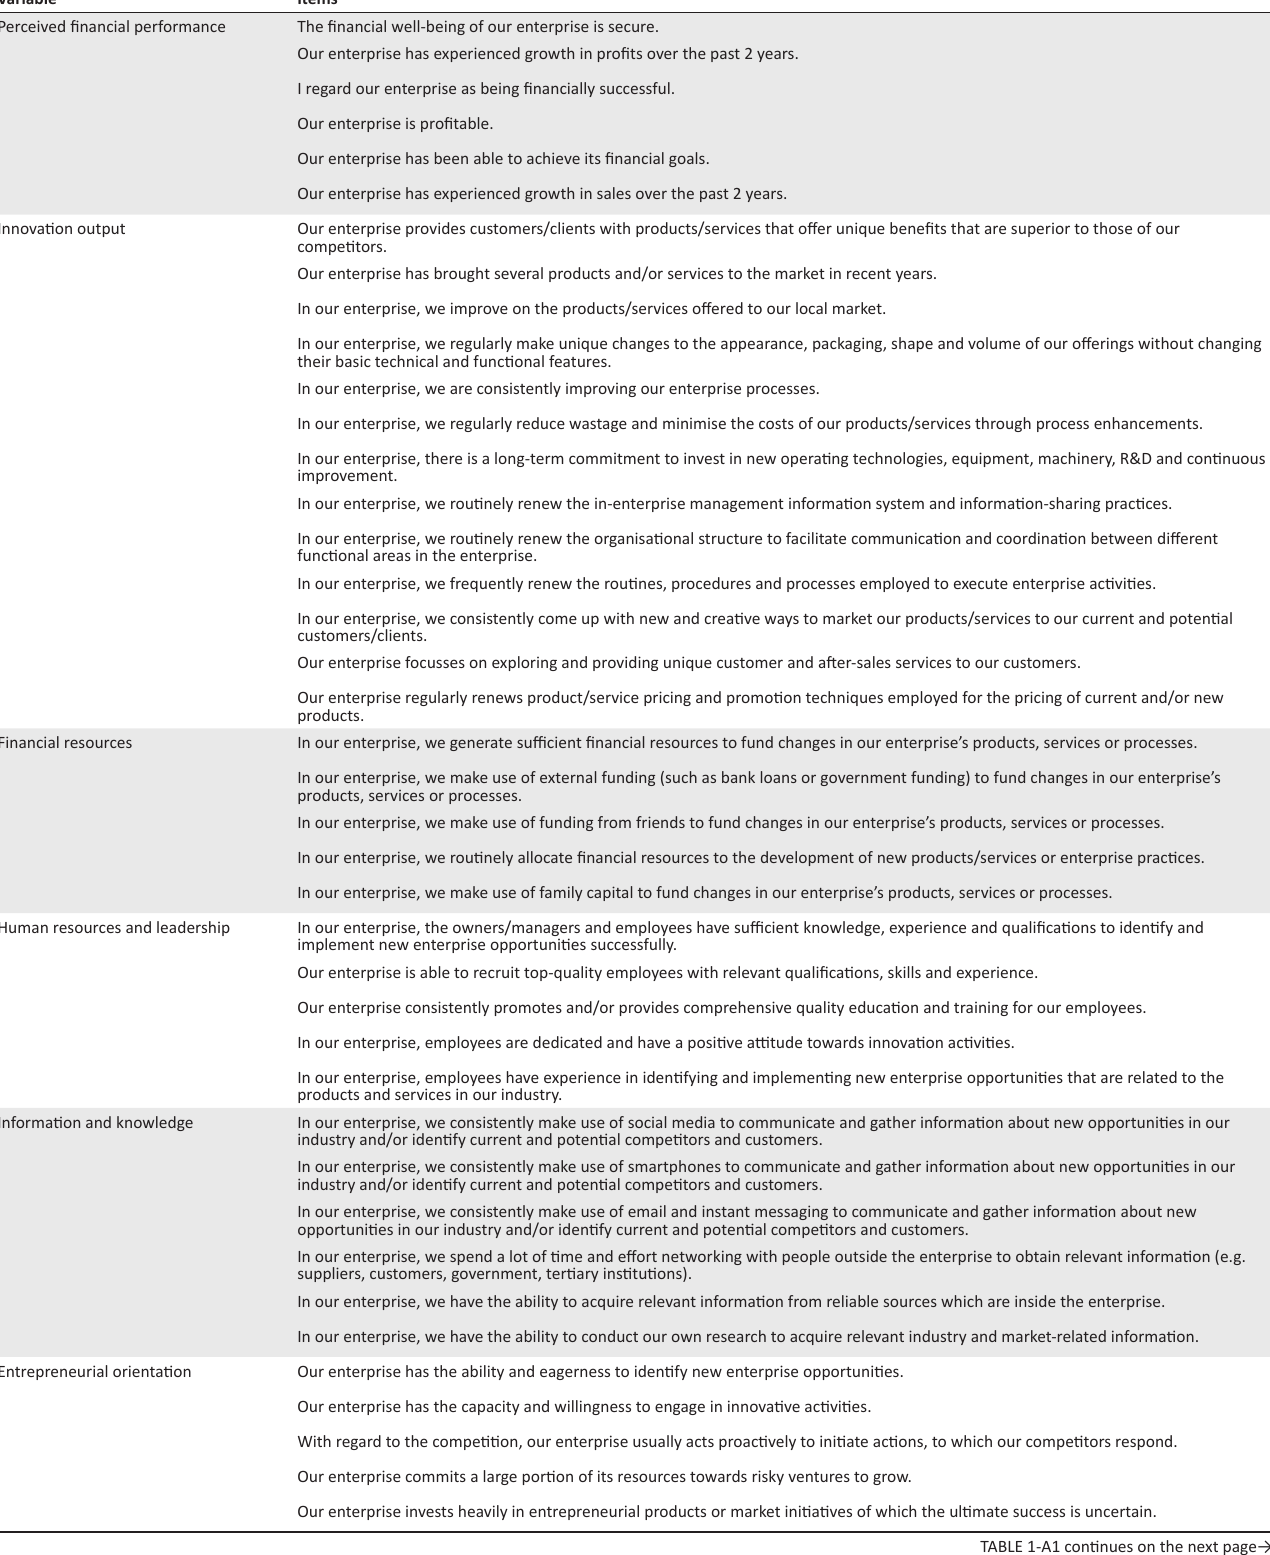
TABLE 1-A1: Items used in the questionnaire.